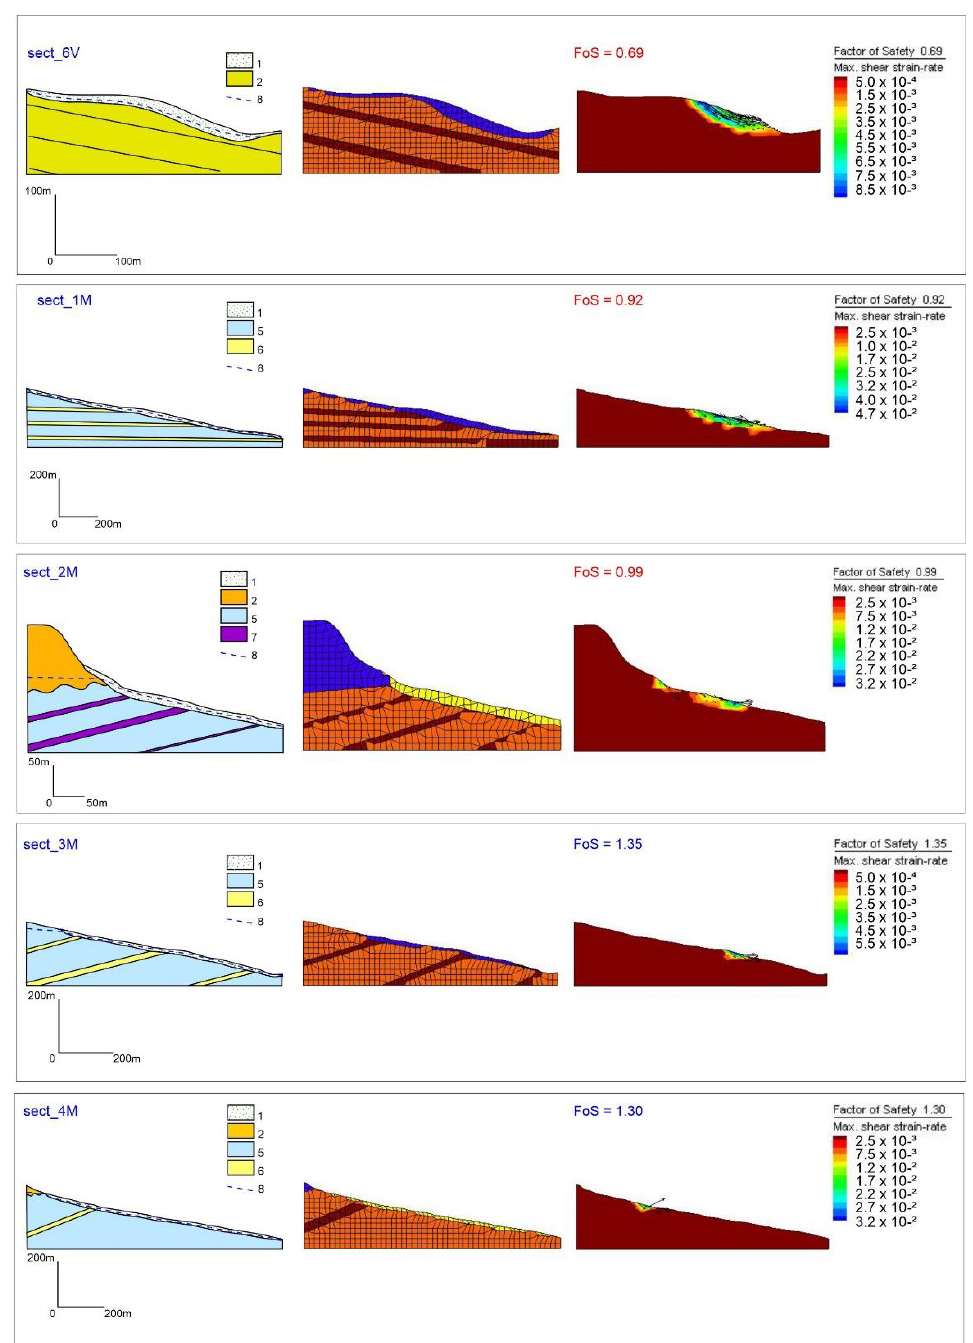
Figure 9. Results of numerical simulation (Sections 6V, 1M, 2M, 3M, 4M). From left to right: geotechnical cross-section, mesh and model result. 1—slope and colluvial deposits; 2—arenaceous-conglomeratic bedrock; 3—arenaceous-pelitic and pelitic-arenaceous bedrock; 4—mainly clayey bedrock; 5—mainly pelitic-arenaceous bedrock; 6—mainly arenaceous-pelitic bedrock; 7—weak layer/ductile deformation zone; 8—water table.